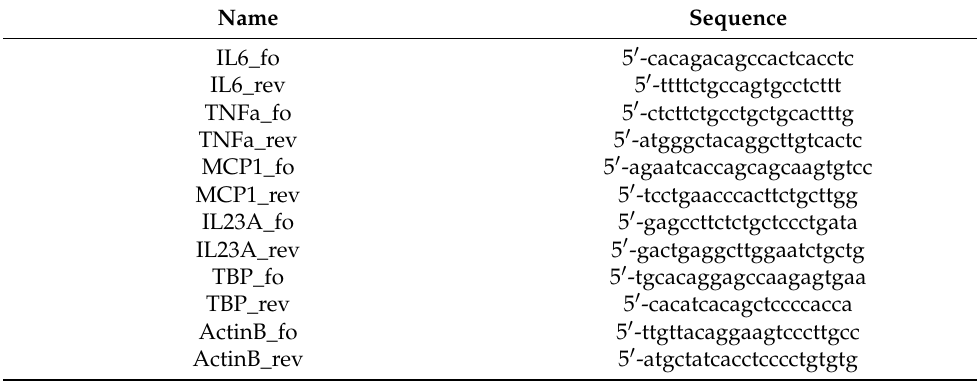
Table 1. Primer sequences (Forward (fo) and reverse (re) primer sequences for quantitative real- time